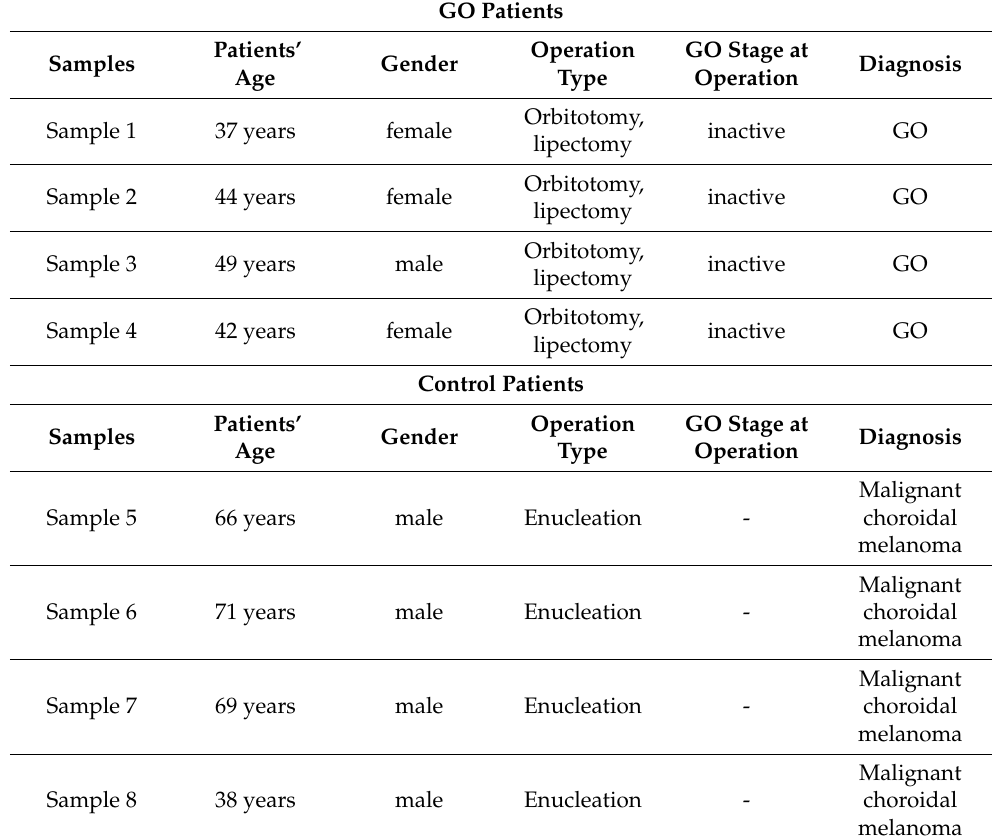
Table 2. Origin of primary orbital